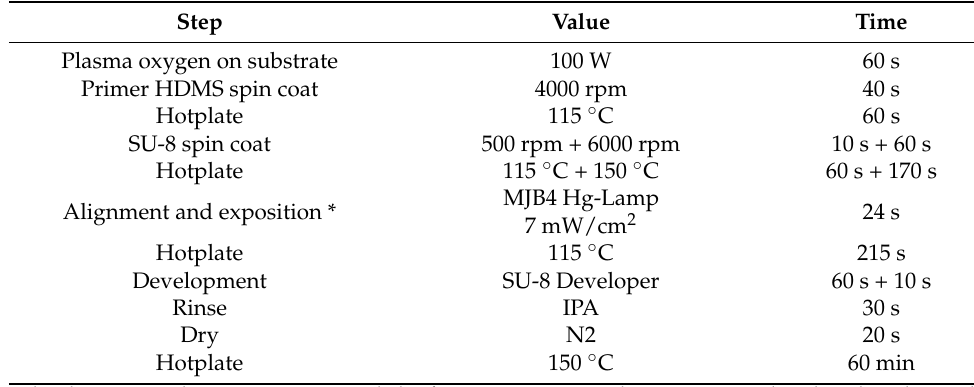
Table 5. SU-8 guiding layer